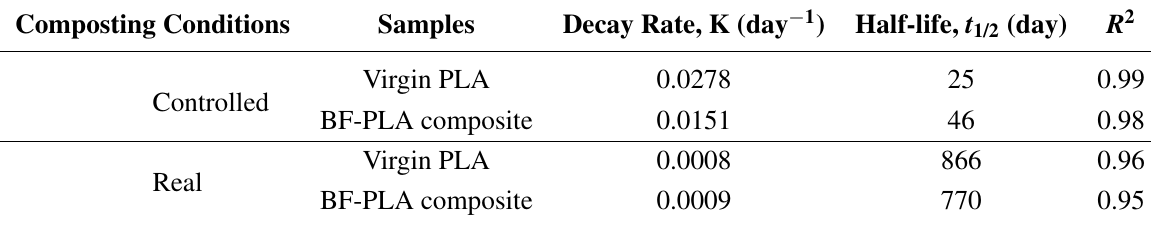
Figure 12. Degree of biodegradation against degradation time for virgin PLA composite and BF-PLA composite a, virgin PLA in controlled composting condition; b, virgin PLA in real composting condition; c, BF-PLA composite in controlled composting condition; and d, BF-PLA composite in real composting condition. Table 5. Decay rate and half-life of virgin PLA and BF-PLA composites in controlled and real composting conditions.